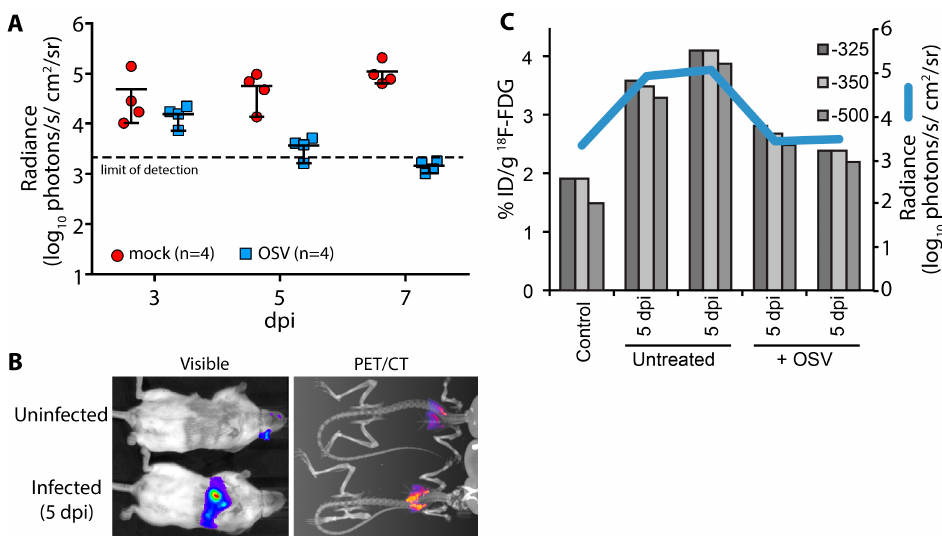
Figure 4. Multi ‐ modal imaging of the effect of antiviral treatment on influenza virus ‐ mediated inflammation. ( A ) Infected mice were treated with oseltamivir (OSV, 10 mg/kg bid) beginning 2 days post infection (dpi) or mock treated; Serial bioluminescence imaging of the same cohort of animals was used to detect statistically significant differences in viral load over time between mock and OSV treatment ( p = 0.0085, 2 ‐ way ANOVA); ( B ) Multi ‐ modal bioluminescence and positron emission tomography–computed tomography (PET/CT) imaging. [18F] ‐ 2 ‐ deoxy ‐ 2 ‐ fluoro ‐ D ‐ glucose ( 18 F ‐ FDG) was used as a probe to measure inflammation in the lungs. Representative data from uninfected and infected mice are shown; ( C ) Dual quantification of viral load (bioluminescent radiance) and inflammation (% ‐ injected dose(ID)/g) in the lungs of infected or control mice. Three different Hounsfield unit thresholds were used to define lung tissue by CT from which 18 F ‐ FDG was quantified by PET. Data were collected from one control mouse, two infected mice, and two infected mice treated with OSV.